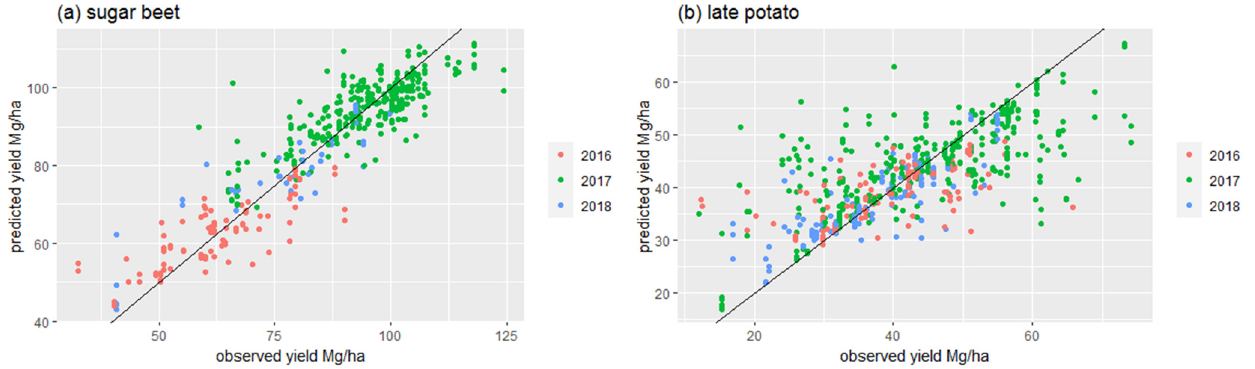
Figure 5. Modeled versus predicted yield for ( a ) sugar beet and ( b ) late potato as predicted by the random forest Model 4: yield = approximately aNDVI + monthly P + monthly Tmax + monthly SDrz (see Table 2 for model performance indicators and further details).